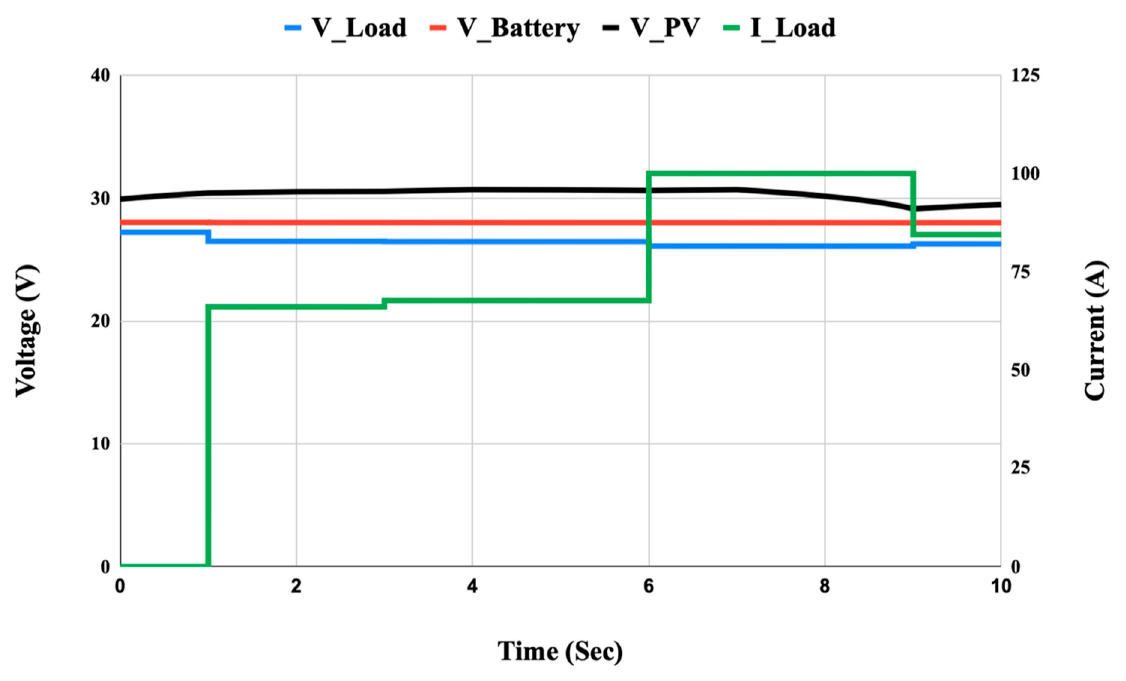
Figure 13. Voltage and current simulation outputs for load under standard efficiency appliances.